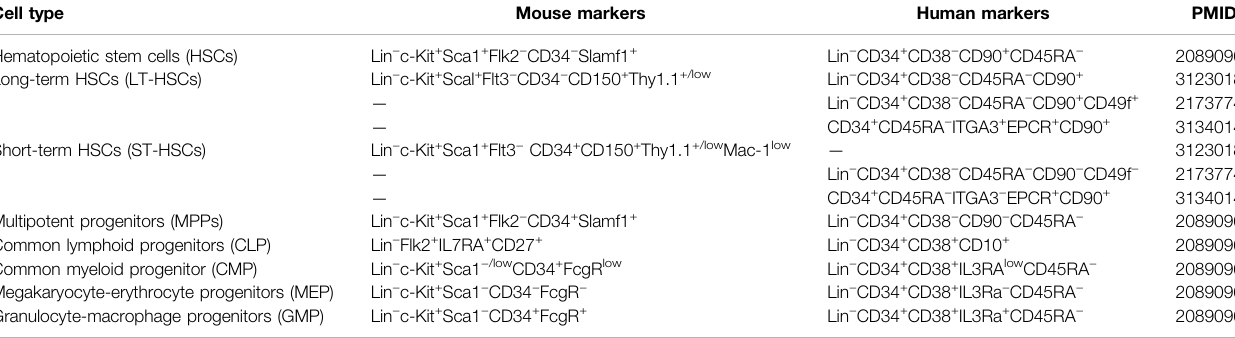
TABLE 2 | Summary of characteristic markers of mouse and human hematopoietic cell population. Cell type Mouse markers Human markers Hematopoietic stem cells